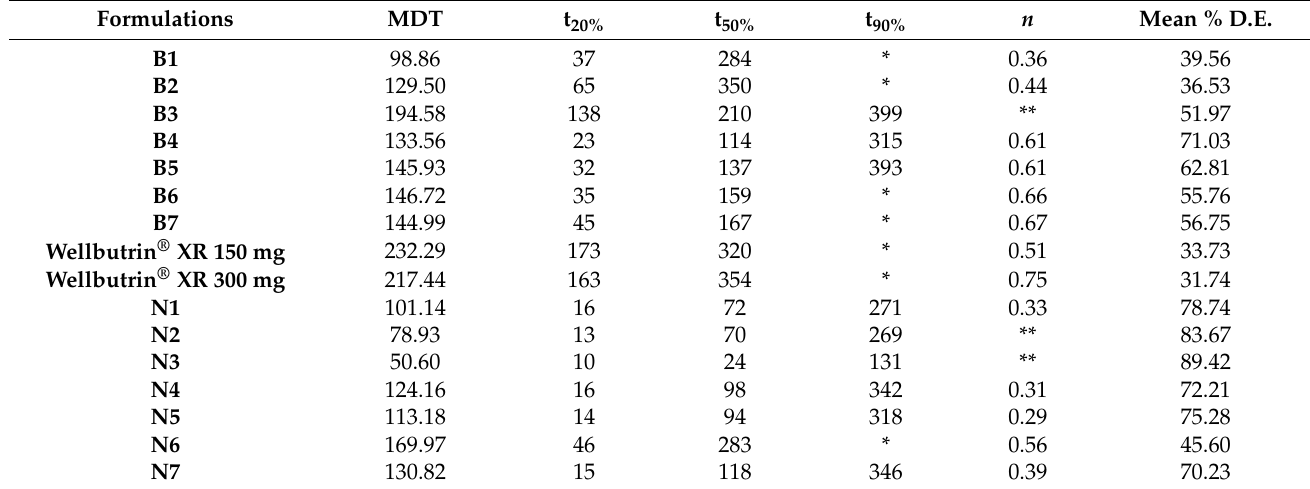
Table 2. Kinetic release properties of the developed formulations (B1-B7, N1-N7), Wellbutrin ® XR 150 and 300 mg.